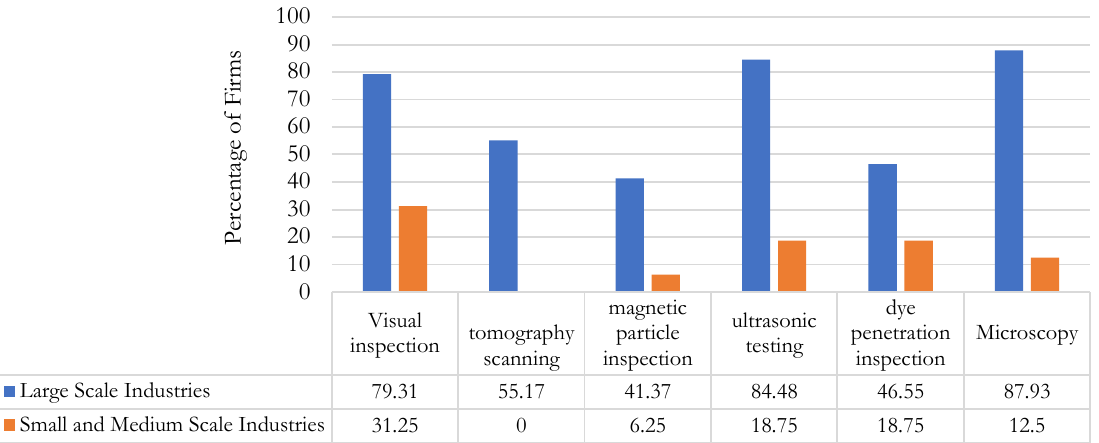
Fig. 10. Methods of quality standards: comparison between both groups of firms.